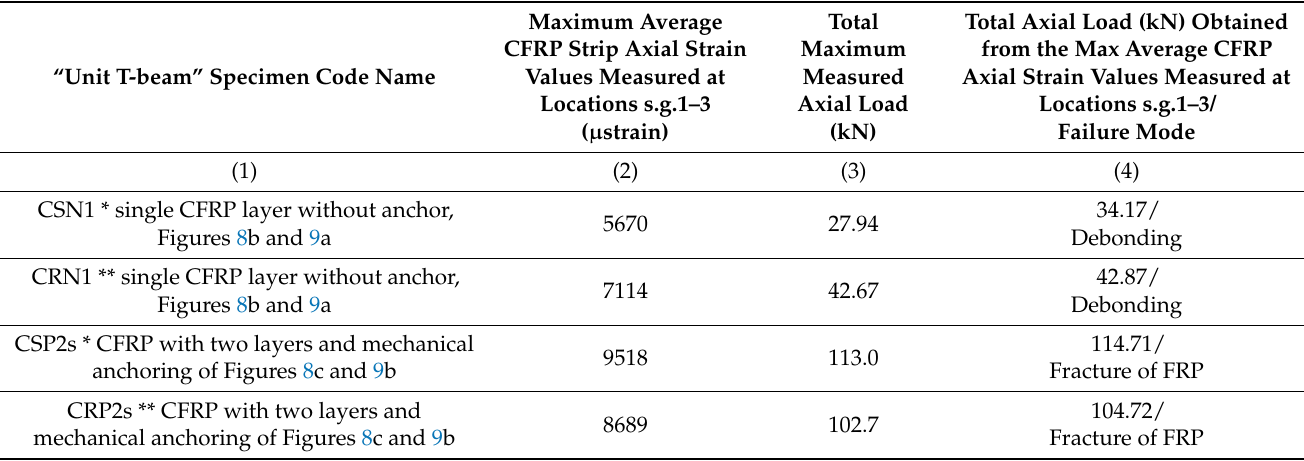
Table 2. Results of “unit T-beam” specimens with open hoop CFRP strips with and without the use of mechanical anchors (Figures 8a–d and